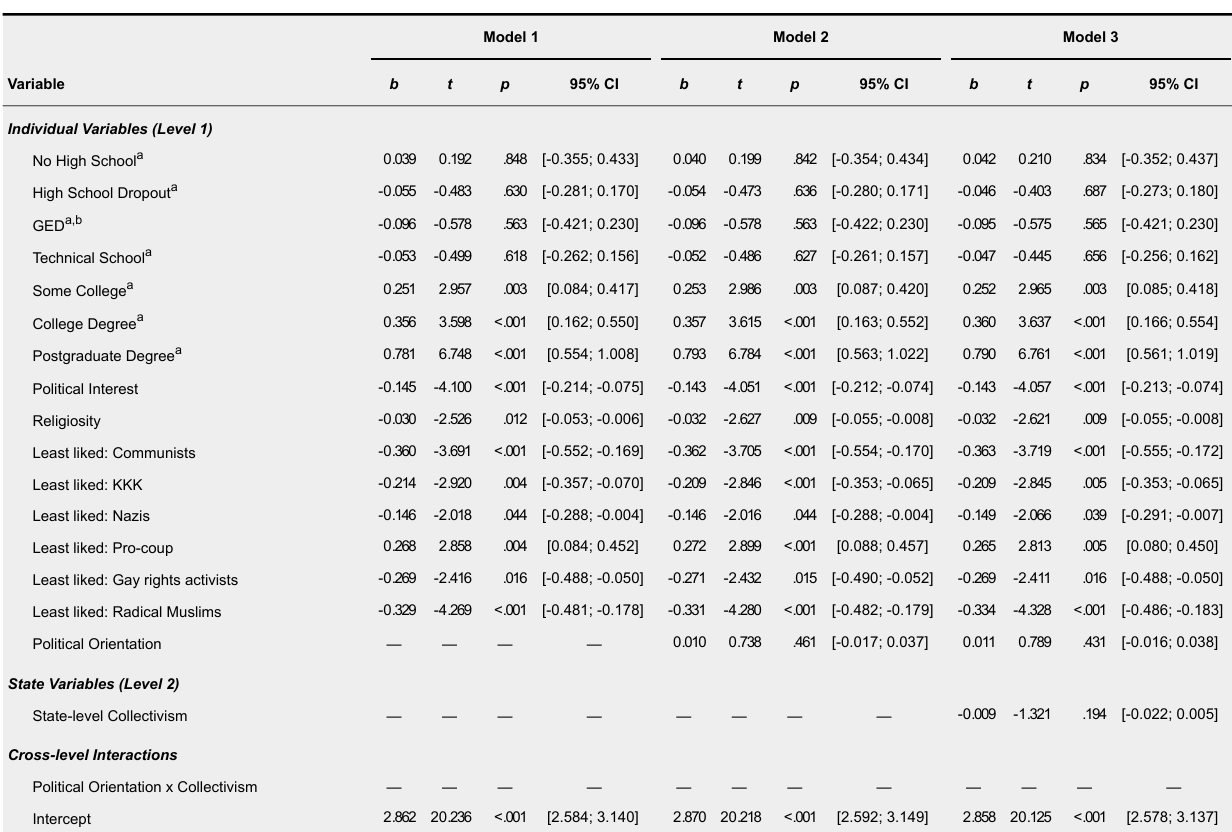
Estimated Coefficients and Significance for Variables in Multilevel Models Measuring Impact of Individualism/Collectivism and Political Orientation on Support for Free Speech (Study